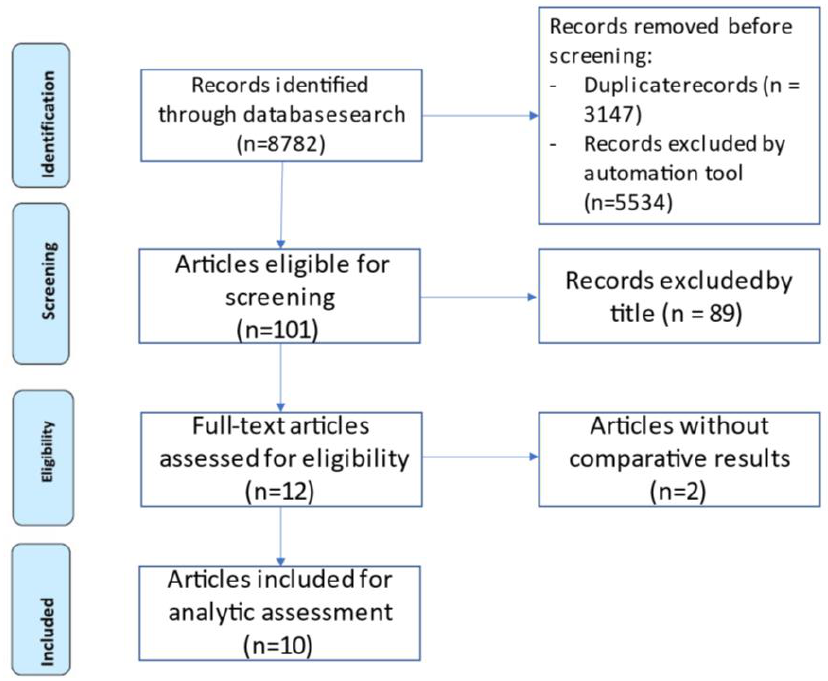
Figure 3. Systematic review flow diagram. The PRISMA flow diagram for the systematic review detailing the database searches and the number of articles screened for the title, abstract, and full-text. Table 1. Summary of the 10 studies included in this umbrella